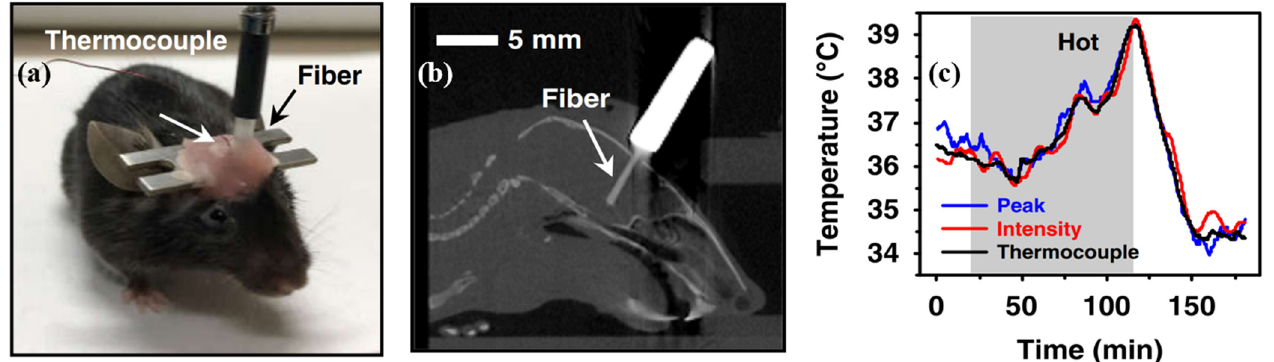
Figure 7. OE fiber-integrated devices for in vivo temperature sensing (Reprinted with permission from ref. [180]. Copyright 2022 He Ding et al.): ( a ) a mouse implanted with a fiber sensor for temperature detection; ( b ) sagittal CT slice reconstruction; and ( c ) dynamic temperature data acquired by the fiber sensor in the mouse brain.